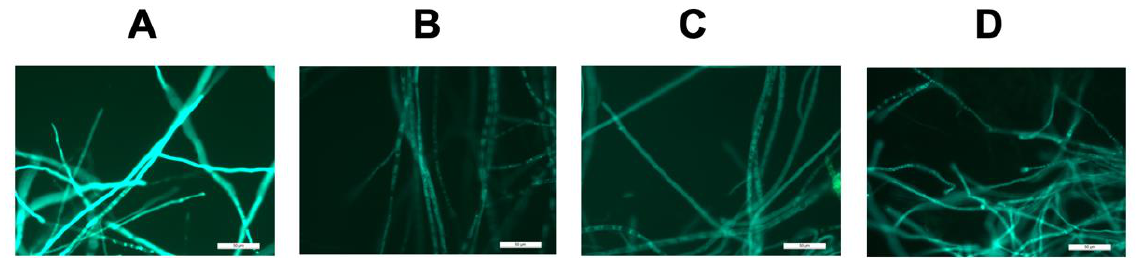
Figure 3: Green fluorescent imaging of: ( A – C ) transformants with PCC subunit genes fused to eGFP ; ( D ) DEBS1-TE fused to eGFP. Scale bar 50 μ m.